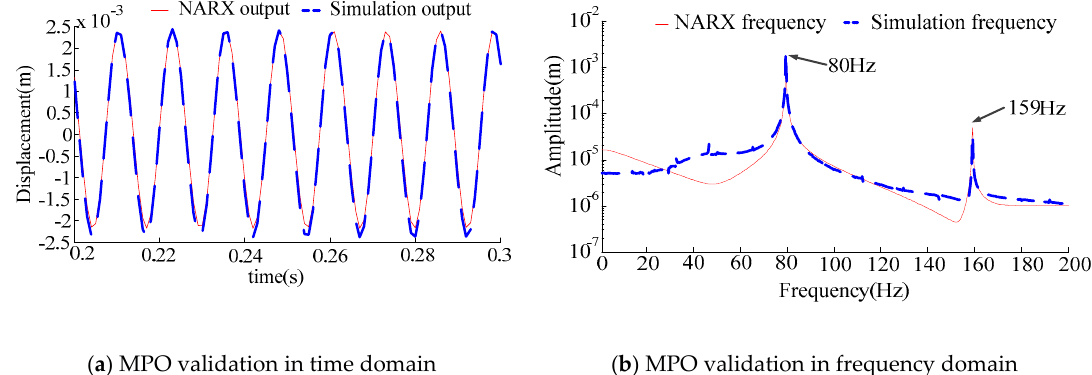
Figure 11. Output comparison in time and frequency domain at an over critical speed.